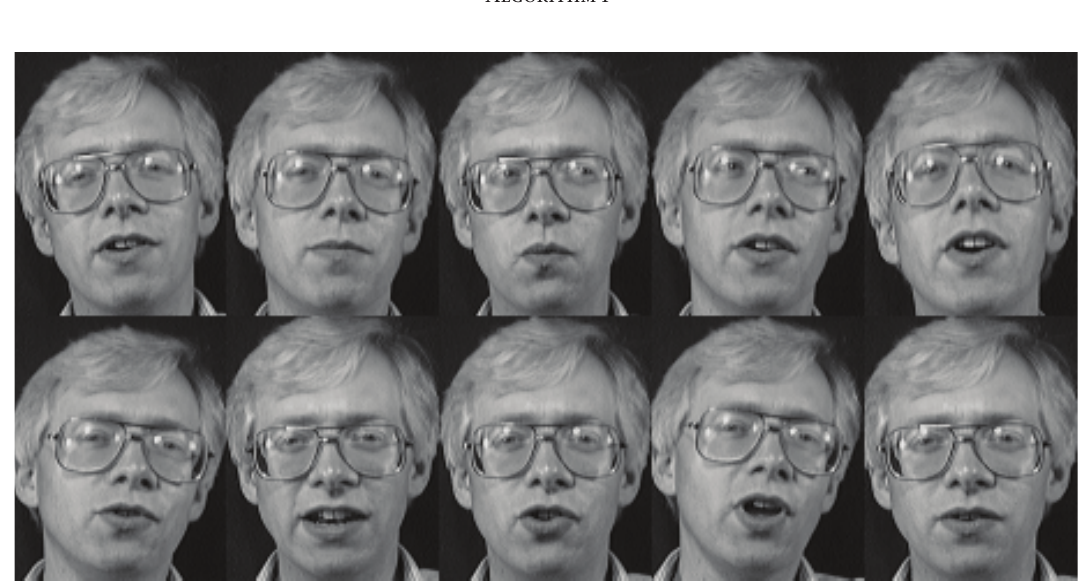
Figure 2: Images of one person from the ORL face